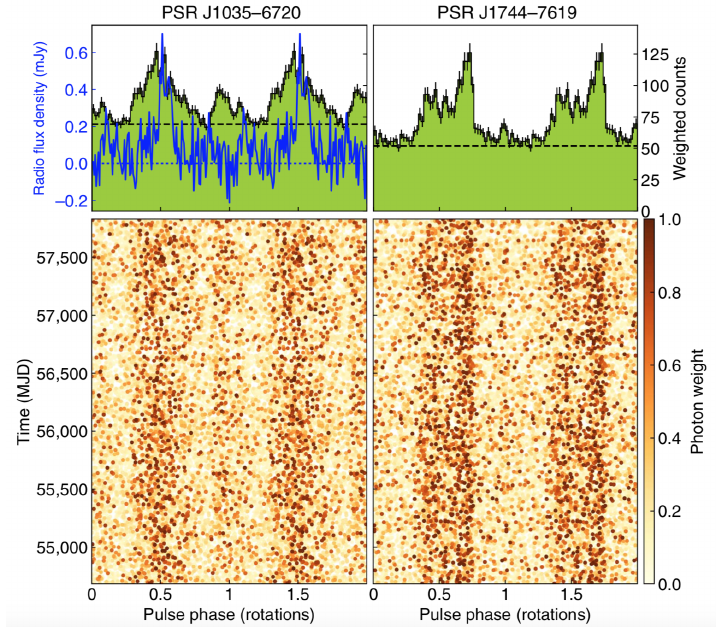
Figure 5. Rotational phases of individual γ rays ( bottom ) and integrated pulse profiles ( top ) of the newly detected millisecond pulsars. Each photon has been assigned a weight, determined by its energy and arrival direction, representing the probability of it having come from the γ -ray source in question. The blue line is the radio signal from PSR J1035 − 6720 [25]. ( c (cid:13) American Association for the Advancement of Science. Reproduced with